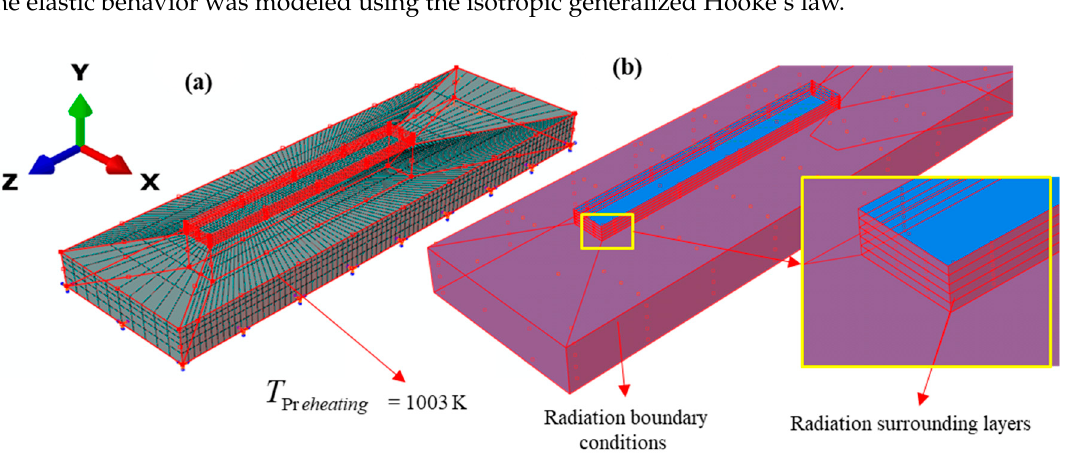
Figure 2. ( a ) Preheating temperature for the whole model. ( b ) Radiation surrounding the base plate and deposited layers.